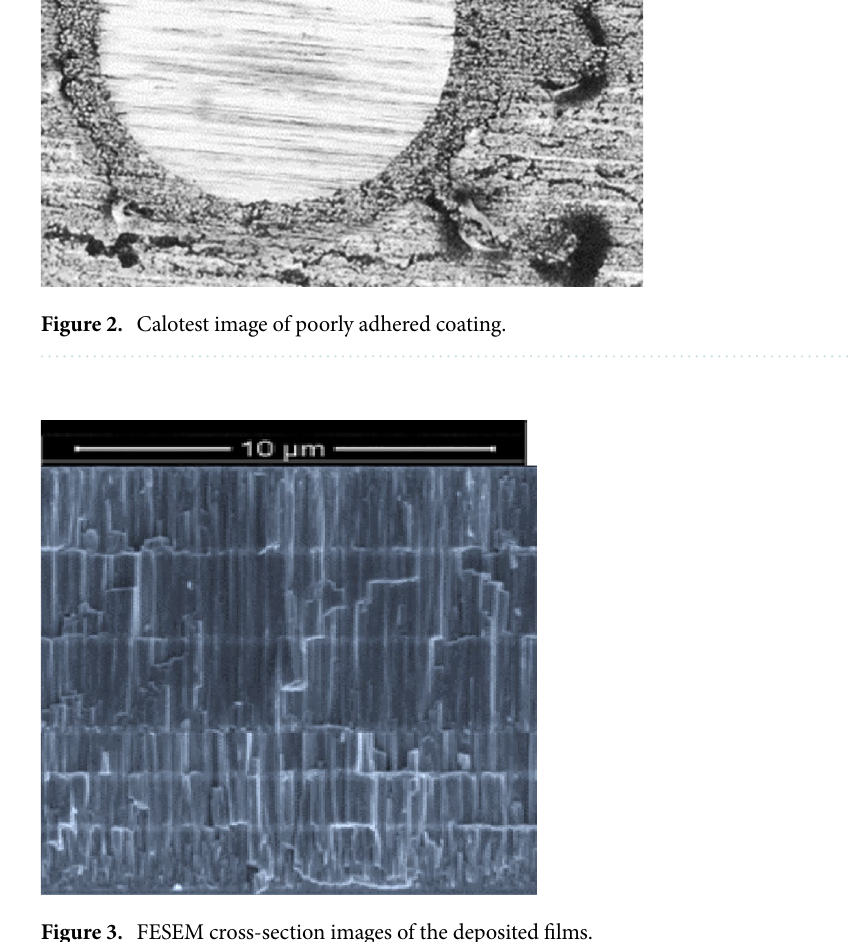
Figure 3. FESEM cross-section images of the deposited films.